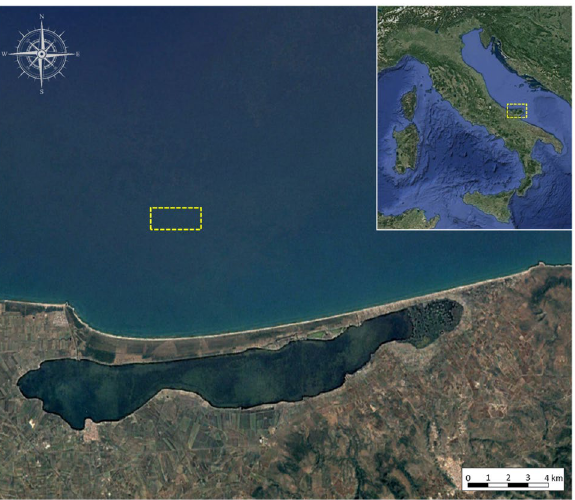
Figure 1. Studied area in the Adriatic Sea in Italy. The yellow dotted line signs the position of operating mussel farm under which the sea cucumber rearing cages were located. Attribution: image ©2022 Google Earth, data SIO/NOAA/U.S.Navy, NGA,GEBCO.